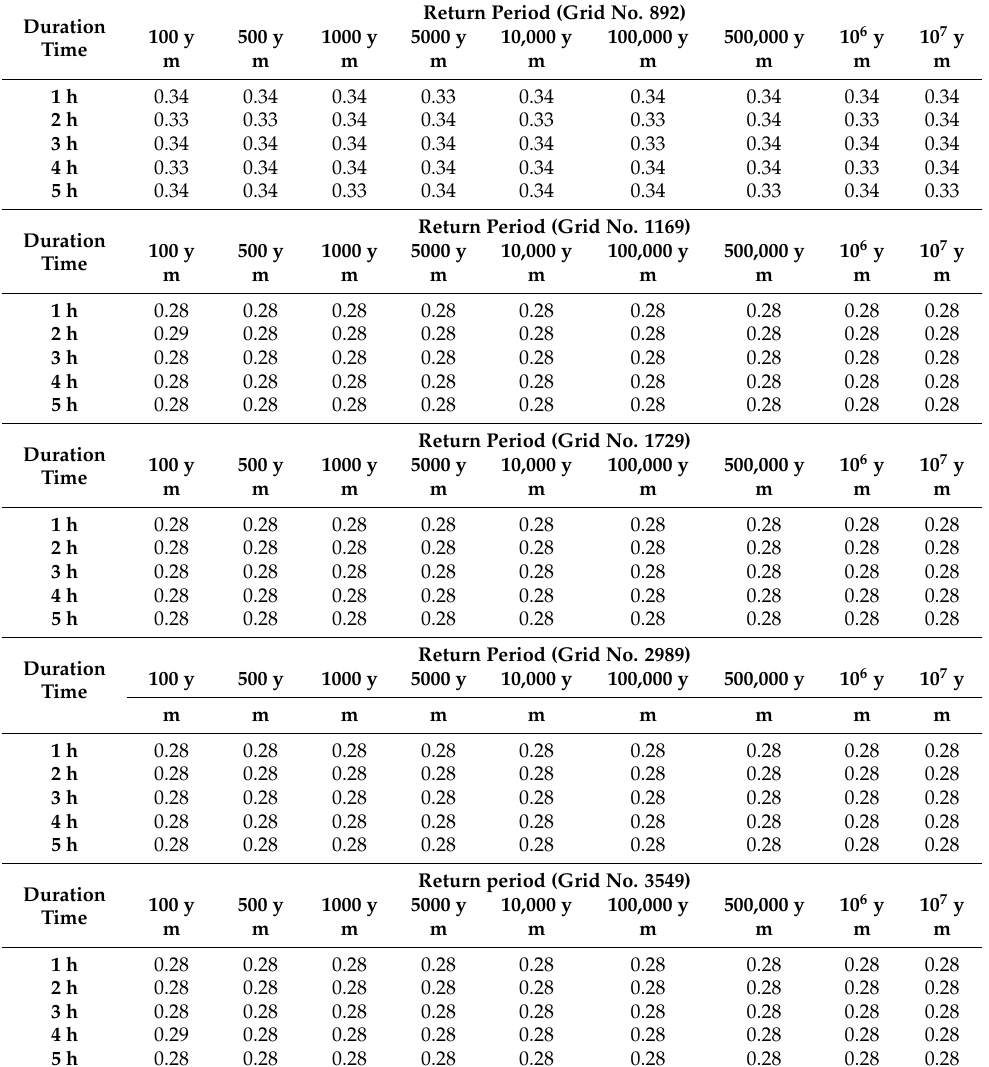
Table 10. Maximum flood depths for probabilistic analysis in the control building of NPP 4 (elevation 80